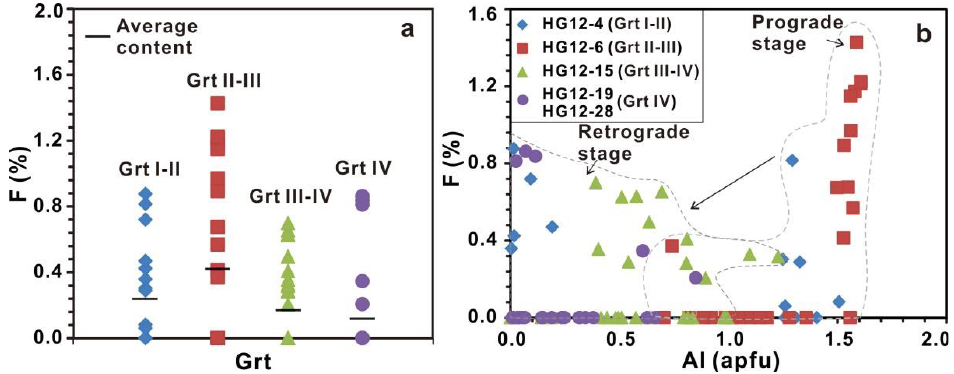
Figure 10. ( a ) F concentrations in garnets from the Huanggang deposit. ( b ) F concentrations versus total Al in atoms per formula unit (apfu) from the Huanggang deposit.